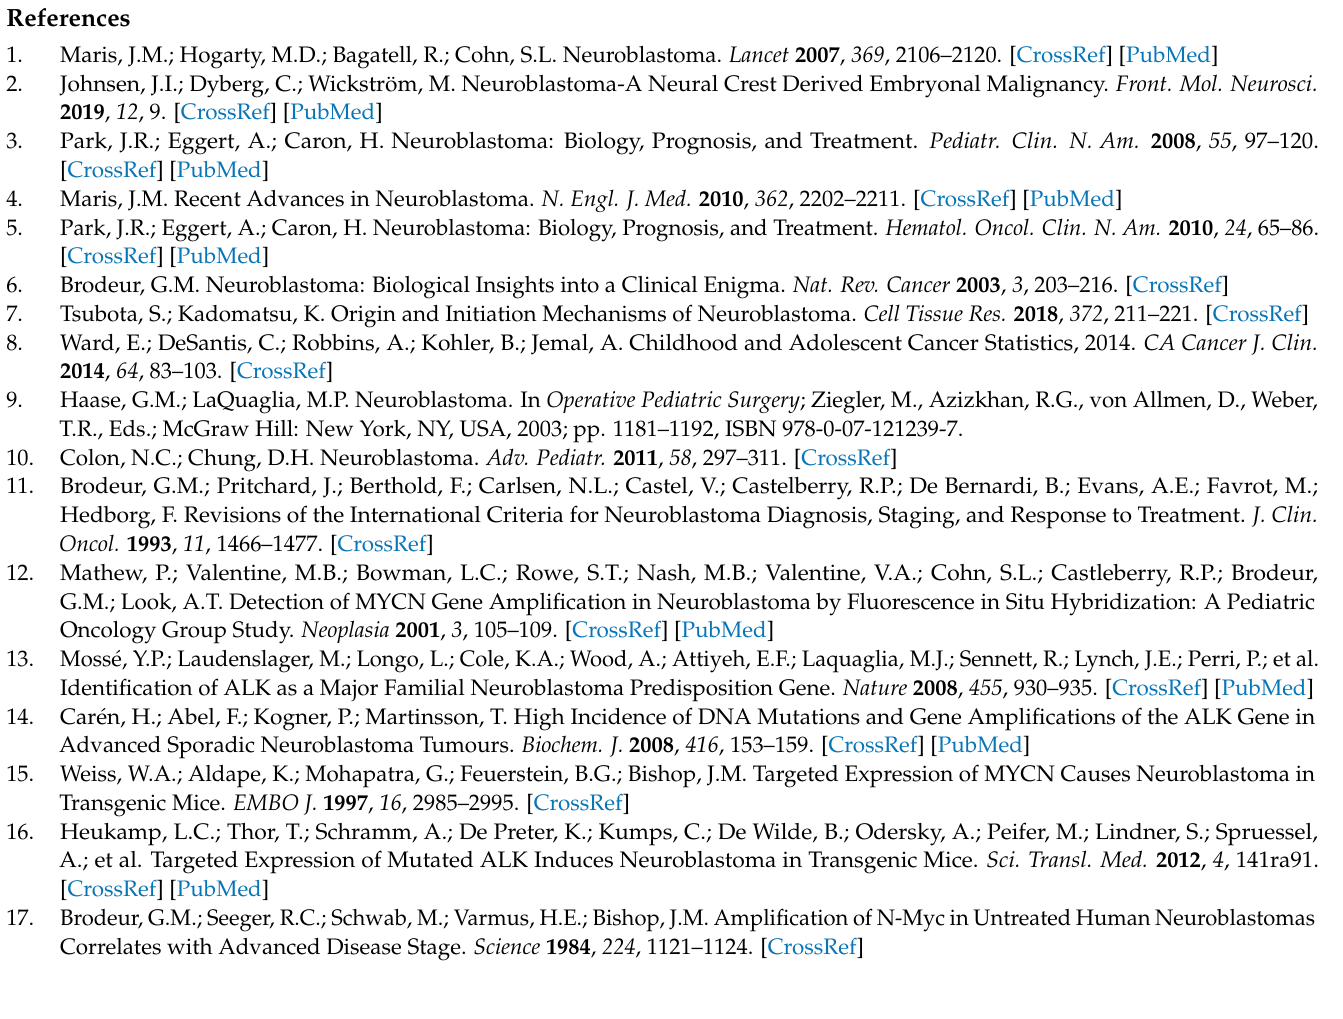
Table S2: Gene Ontology analysis based on Biological Processes; Table S3: Gene Ontology analysis based on Cellular Components. Figure S1: Normalized data used to identify DEGs. In green stage 1 tumor samples and in violet stage 4 + 4S. Total number of samples (box plots) is 445. This makes difficult the visualization of the sample names but it is possible to see that the median of the fluorescence intensity is the same for all the samples (lane in the middle of each